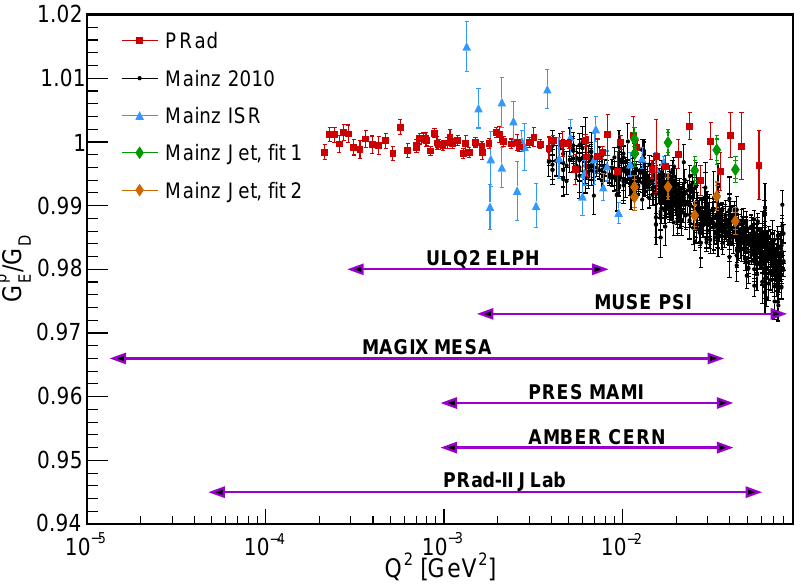
Figure 8. The proton electric form factor, normalized by the standard dipole form factor, from the PRad experiment [3] (red squares), the Mainz 2010 experiment [2] (black dots), the Mainz ISR experiment [4] (blue triangles), and Mainz jet target experiment [56], where green diamonds are fitted to PRad parameterization and orange diamonds are fitted to Mainz 2010 parameterization. Also shown on top, are the expected Q 2 coverages from future experiments including MUSE [120–122], PRad-II [123], AMBER [124,125], PRES [126,127], MAGIX [80] and ULQ2 experiments